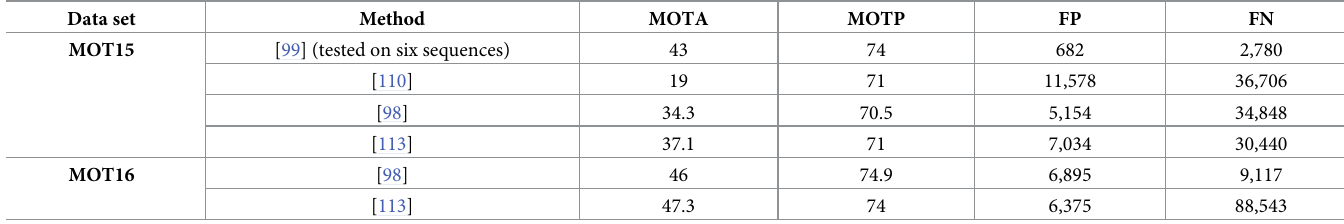
Table 1. Comparison of several discussed brain-inspired